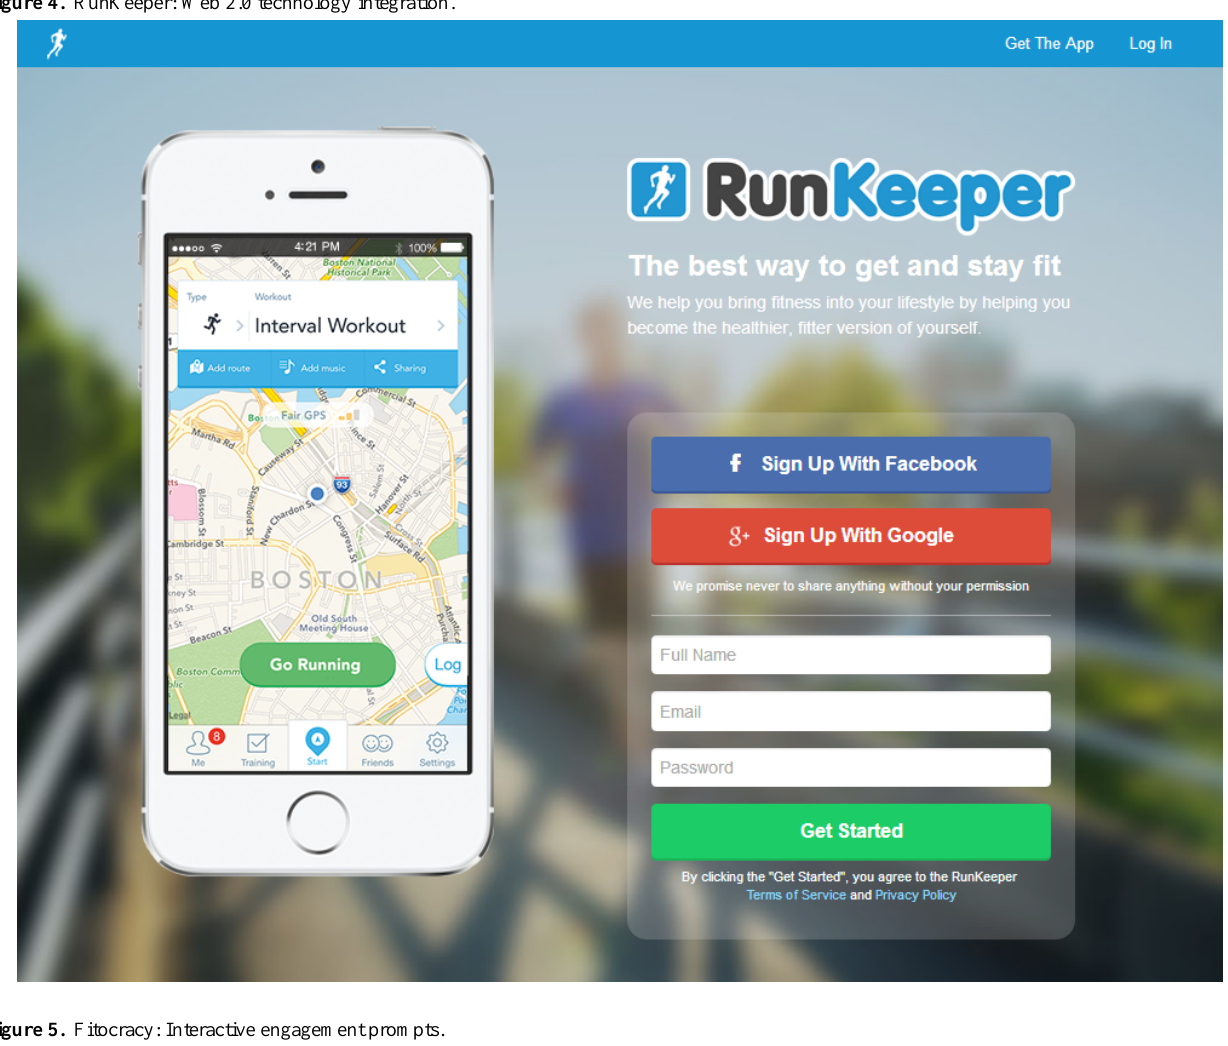
Figure 4. RunKeeper: Web 2.0 technology integration.